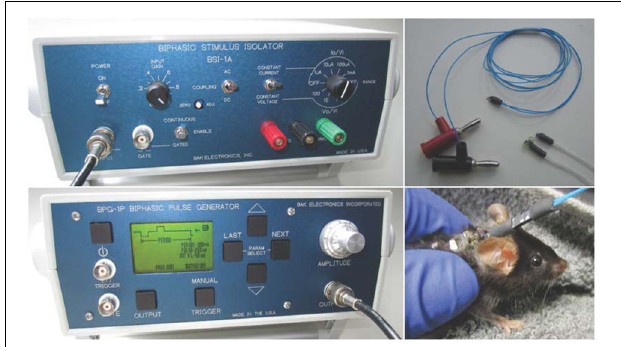
FIGURE 2 | Left panel (top to bottom): Biphasic current-controlled stimulus isolator and biphasic pulse generator (BSI-1A, BPG-1P, respectively; Bak Electronics Incorporated, Umatilla, FL, United States). Right panel (top to bottom): Omnetics mating plug for the externalized connector and awake animal receiving stimulation. All procedures described and animal photography was performed with approval by the Institutional Animal Care and Use Committee (IACUC) at the University of